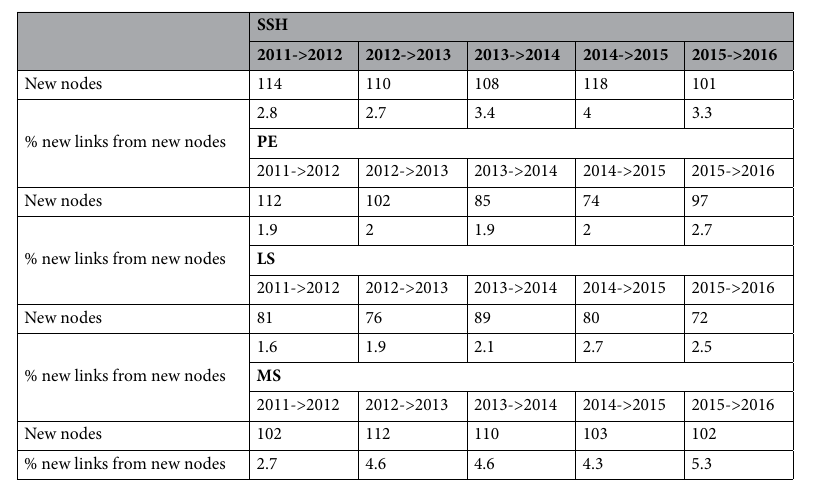
Table 2. Number of new nodes and percentage of edges from new nodes over time and by scientific domain. New edges can emerge from and connect to any node, old or new.